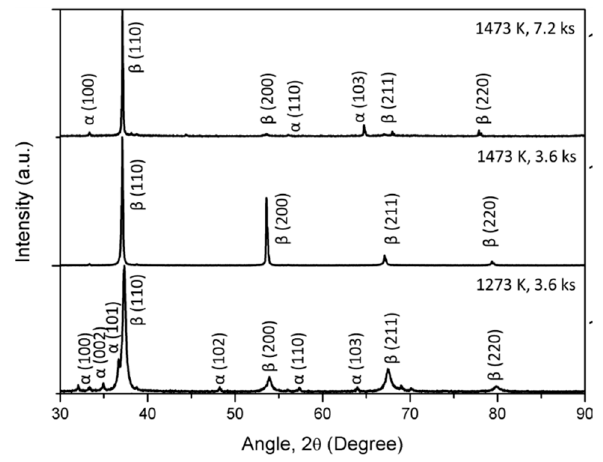
Figure 6. XRD patterns of the TiNbZrHfTa compacts prepared by the hydride process. Table 6. Lattice parameters of the alloy compacts prepared by the hydride process. Lattice Parameters, nm HCP ( α ) BCC ( β